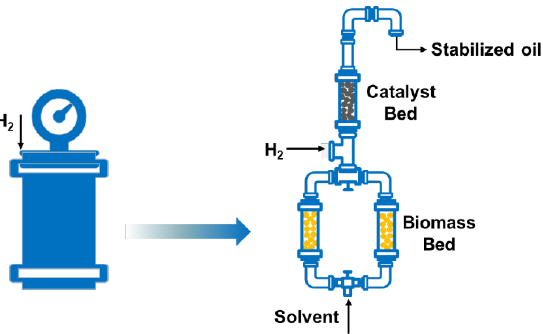
Figure 3. The evolution of reactor configurations for reductive catalytic fractionation.